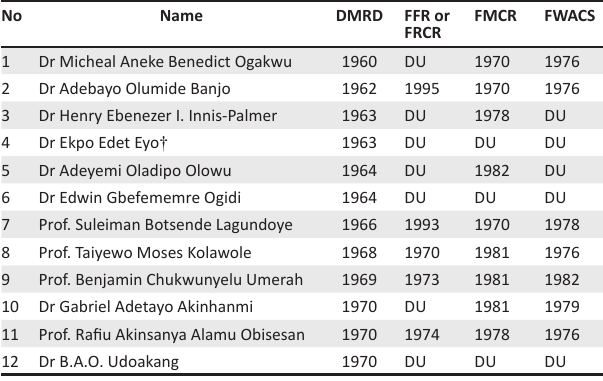
TABLE 1: Pioneer radiologists in